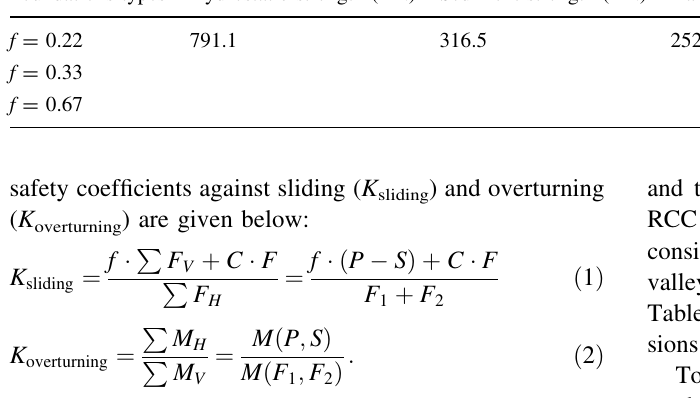
Table 4 Results of dam’s stability analysis—RCC variant Foundations types Hydrostatic strength (KN) Sediment strength (KN) Dam’s weight (KN) Under pressure (KN) K sliding K